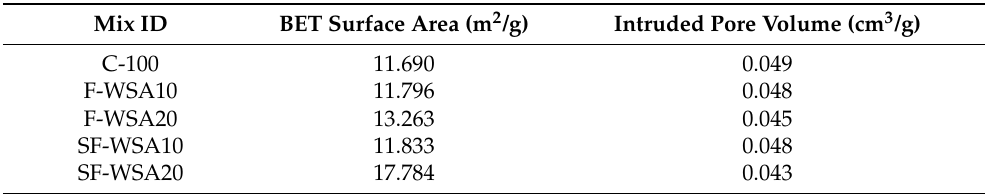
Table 6. BET surface area and intruded pore volume for control (C-100) and other pastes containing F-WSA and